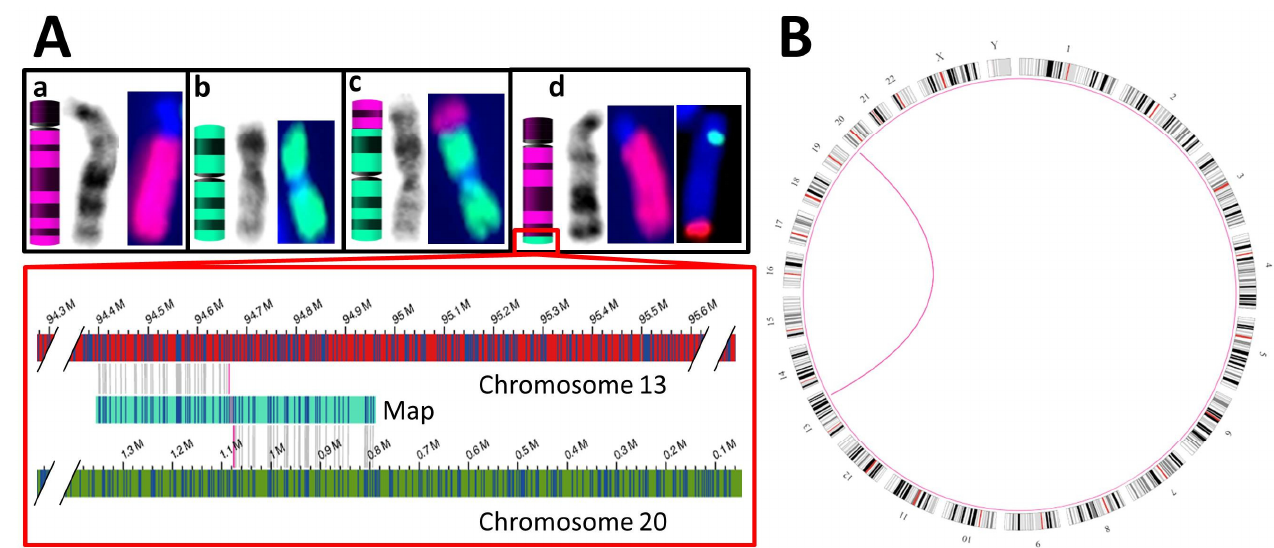
Figure 4. Translocation t(13;20)(q32;p13). ( A ): Normal chromosomes 13 ( a , pink) and 20 ( b , green) are depicted from left to right as ideograms, stained with GTG banding and labeled with whole-chromosome paint (WCP) FISH probes specific for chromosomes 13 and 20, respectively. In ( c ), a variant chromosome 20 is depicted, carrying at its p-arm the terminal portion of the q-arm of chromosome 13. This portion is detectable by GTG banding and WCP-FISH. In ( d ), the variant chromosome 13 is depicted, carrying at its q-arm the terminal portion of the p-arm of chromosome 20. This portion is too small to be detectable by either GTG banding or WCP-FISH. Therefore, FISH probes specific for the subtelomeric region of the p-arm of chromosome 20 (red) and the centromere of chromosome 13 (green) were used. In the rightmost image of ( d ), it is shown that chromosome 13, labeled green at its centromere, carries the subtelomeric region of the p-arm of chromosome 20. The red box shows a close-up view of this breakpoint: here, the left portion of an OGM map (light blue) is aligned to the q-arm of chromosome 13, whereas its right portion is aligned to the p-arm of chromosome 20 (alignment matches indicated by vertical gray lines). The transition between alignments to chromosome 13 and chromosome 20 delineates the breakpoint (shown as vertical red lines). Notably, the map covering the breakpoint is only 500 kbp in length and does not extend far beyond the breakpoint. This is the normal behavior of the employed assembly algorithm. The remaining chromosome is covered by other maps not shown in this image. ( B ): Circos plot generated by the Saphyr system, showing a pink arc between chromosomes 13 and 20, protruding inwards from the breakpoints of the reciprocal balanced translocation.